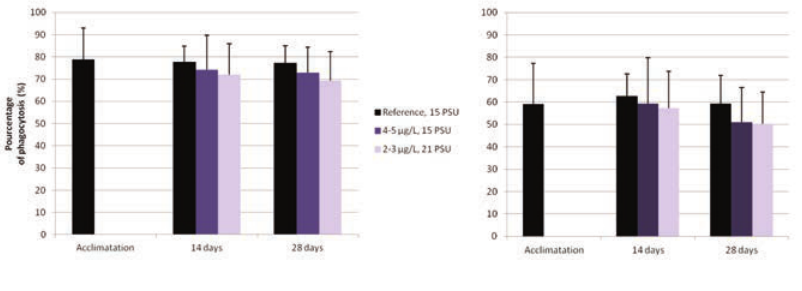
Figure 1. Phagocytic activity (1 bead and more) and phagocytic efficiency (3 beads and more) of blue mussel after 7 days of acclimation as well as after 14 and 28 days of expo- sure to different salinities and concentrations of silver